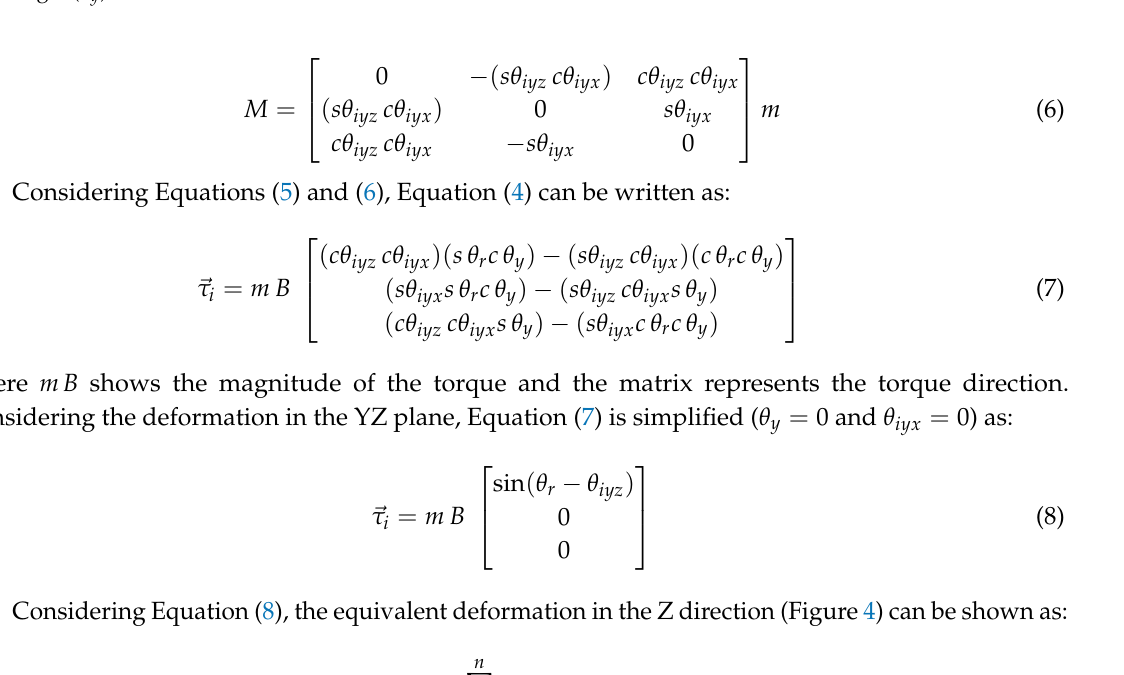
Figure 4. The microrobot steering from the initial position (1) to the desired position (2), deformation in yz-plane under roll angle ( θ r ) is illustrated, similar deformation is assumed in yx-plane under yaw angle ( θ y